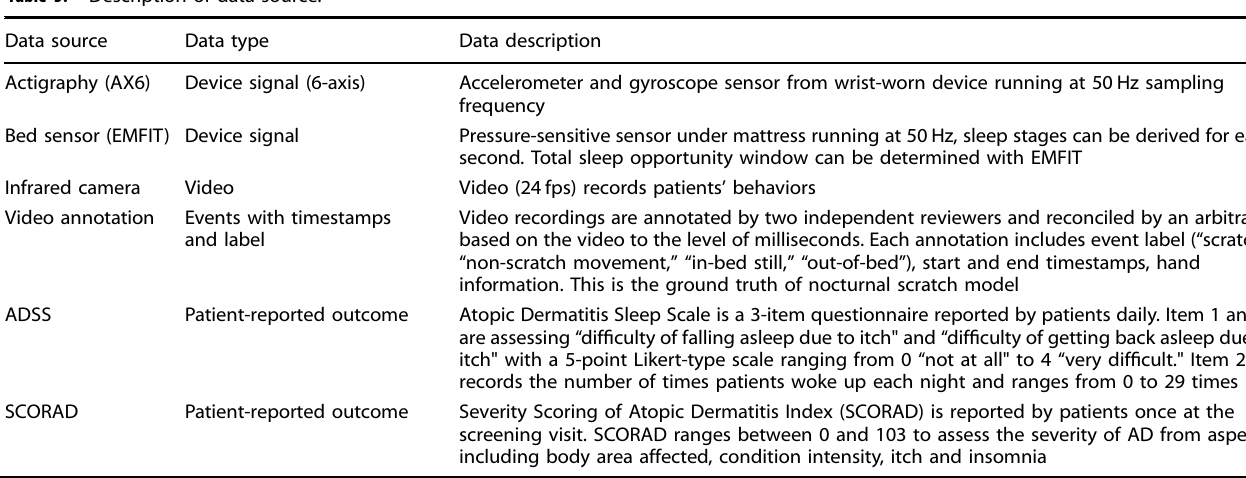
Table 5. Description of data